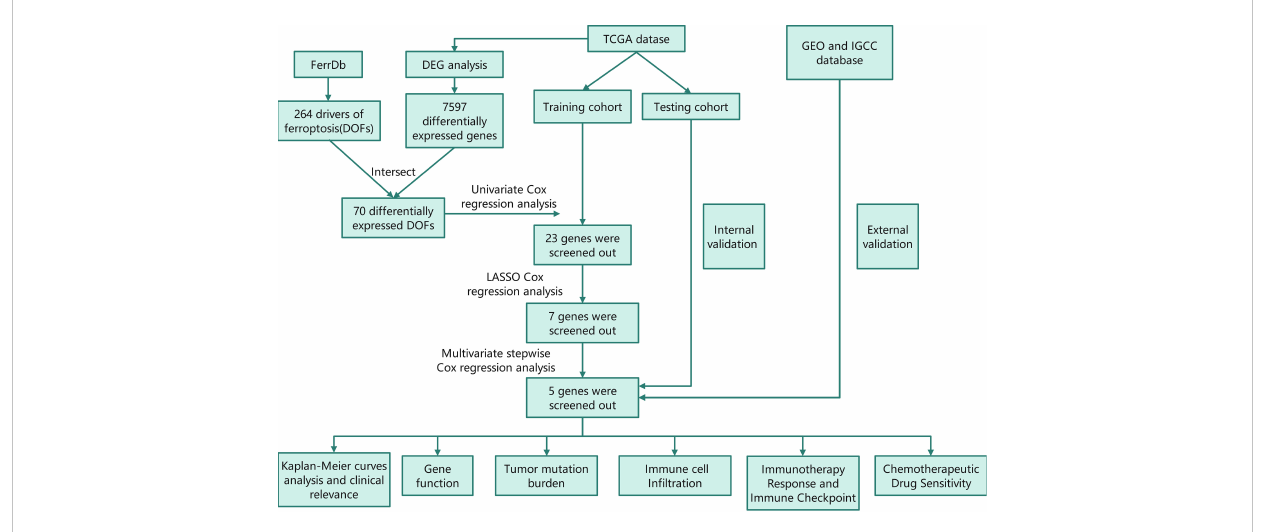
FIGURE 1 Flow chart of this study TCGA, The Cancer Genome Atlas; GEO, The Gene Expression Omnibus; ICGC, The International Cancer Genome Consortium; DEG, differentially expressed genes; DOF, driver of ferroptosis; LASSO, least absolute shrinkage and selection